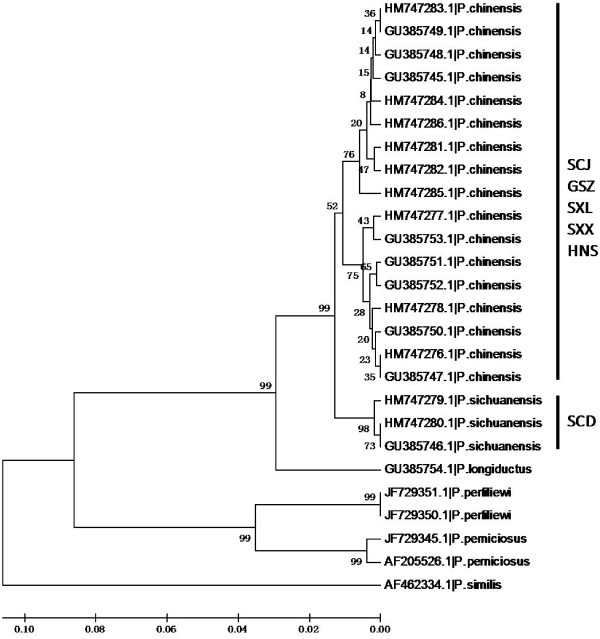
The UPGMA tree of Phlebotomus sandflies inferred by rDNA-ITS2 sequences. The phylogram was generated using MEGA 5.10. The bootstrap values (1000 replications) are shown on the branch. The sequence id is presented by the Genbank accession numbers followed by the species identity. Population id is indicated next to the clades.